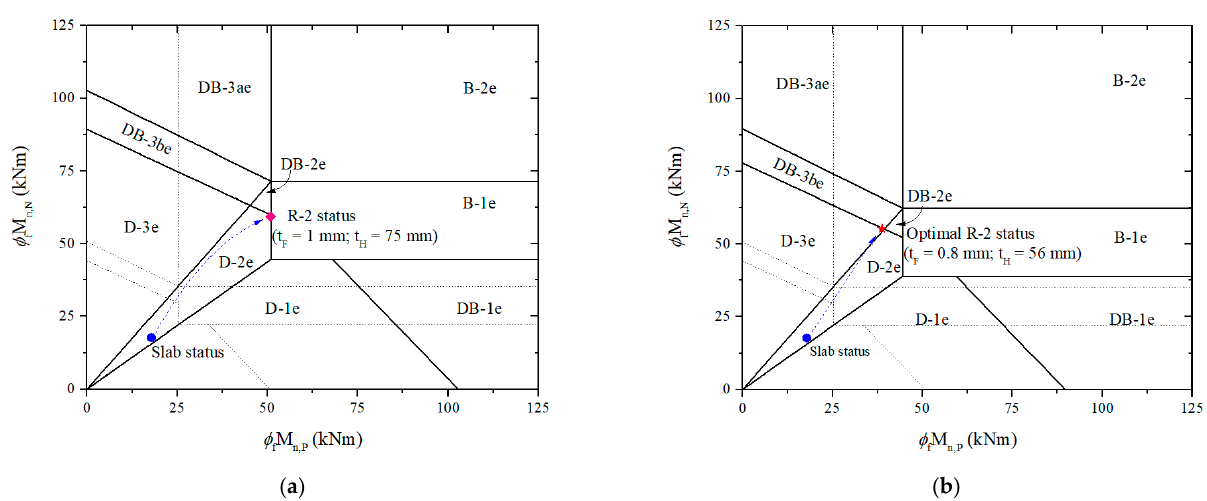
Figure 11. Establish failure limits and predict retrofitted slab status based on moment carrying capacities using the R-2 system, considering ( a ) ductile failure; ( b ) ductile failure and optimal moment ratio.